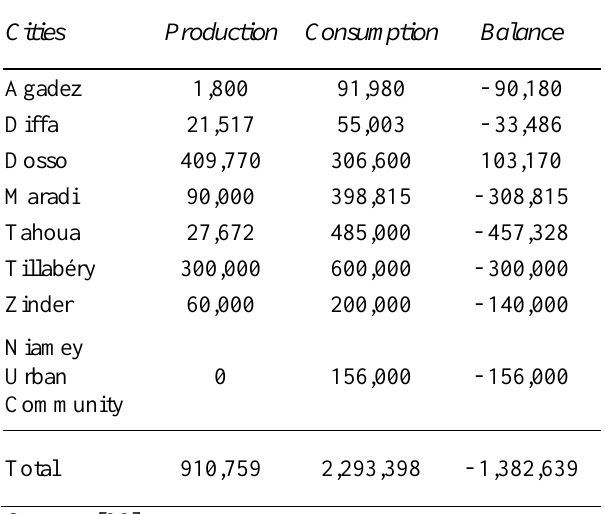
Table 4: Balance of forest productivity and wood energy consumption for regions in Niger - Forest